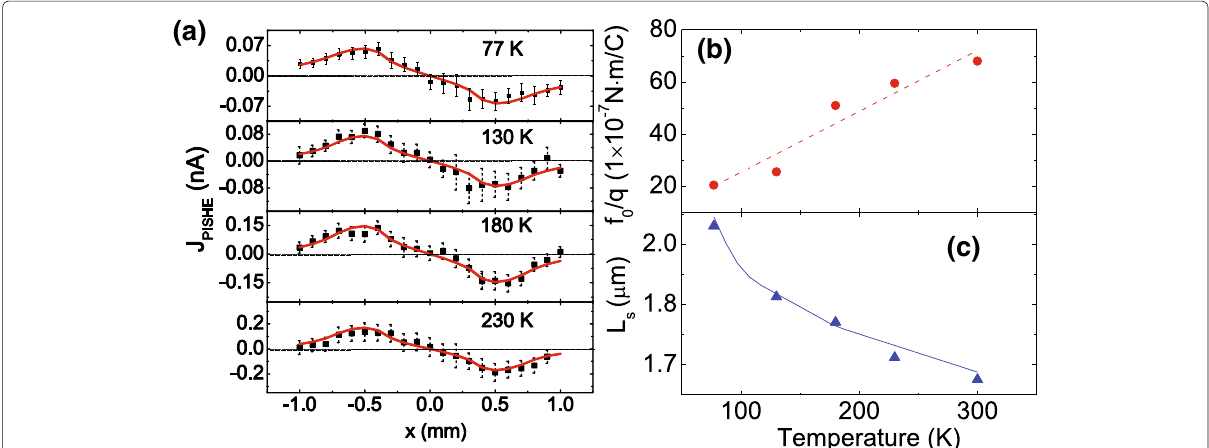
Fig. 4 Temperature dependence of the PISHE current, spin transverse force, and electron diffusion length of the GaAs/AlGaAs 2DEG. a Experimental and modeling results of the PISHE current as a function of the light spot locations measured at different temperatures. The solid squares are the experimental data, and the solid lines are the fitting results. b , c Spin transverse force and electron diffusion length as a function of temperature, respectively. The dashed line in b is the guide for the eyes, and the solid line in c is obtained from